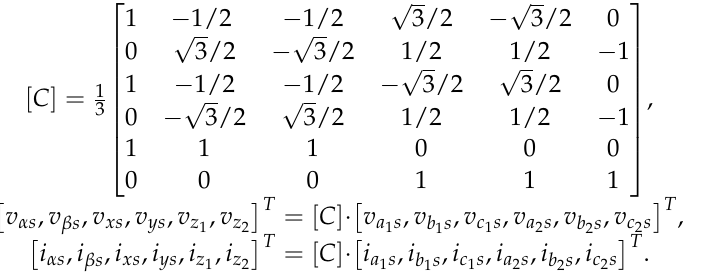
Machines 2023 , 9 , x FOR PEER REVIEW